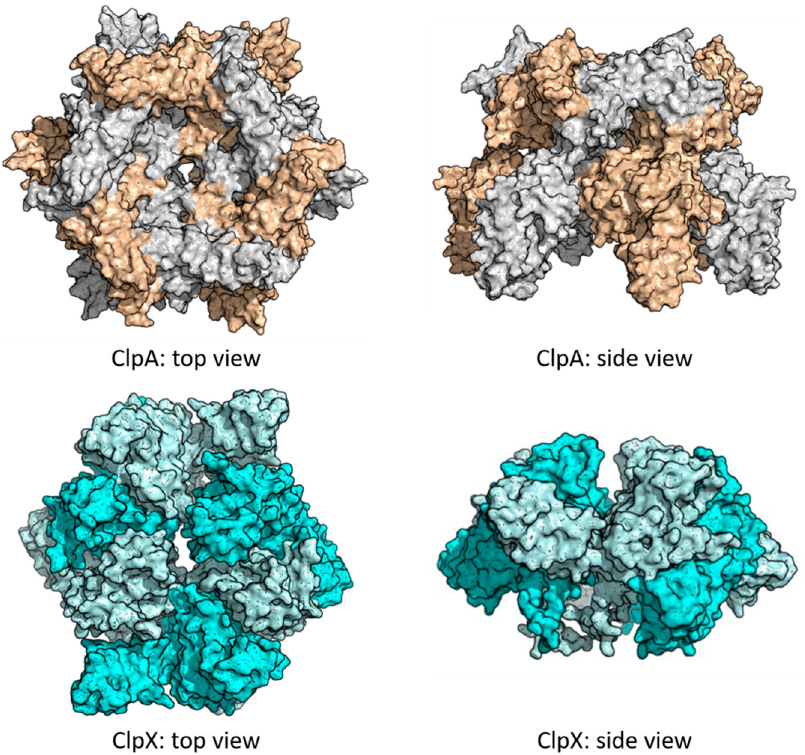
Figure 3. Top and side view of E. coli caseinolytic protease subunit A (ClpA) (top) and E. coli ClpX (bottom) hexamers. The ClpA hexamer is shown in grey and wheat surface representation. The structure was obtained through homology modeling, using the B. subtilis caseinolytic protease subunit C (ClpC) monomer as template (PDB ID: 3PXI) in SWISS-MODEL [42]. The subunits in the ClpC hexamer (PDB ID: 3PXG) where then replaced with the ClpA monomers, and the structure was then relaxed through energy minimization. The caseinolytic protease subunit X (ClpX) hexamer is shown in cyan and light cyan surface representation. Missing loops were modeled using Modeller 9.17 [43].